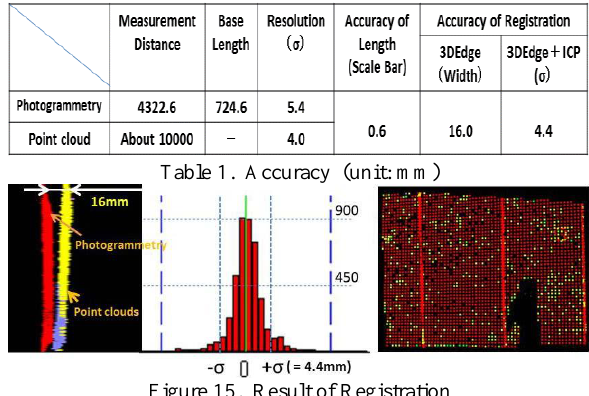
Figure 15. Result of Registration Left: 3D Edge Method, Middle : Histogram of 3D Edge +ICP , Right: Distribution of errors of 3D Edge +ICP